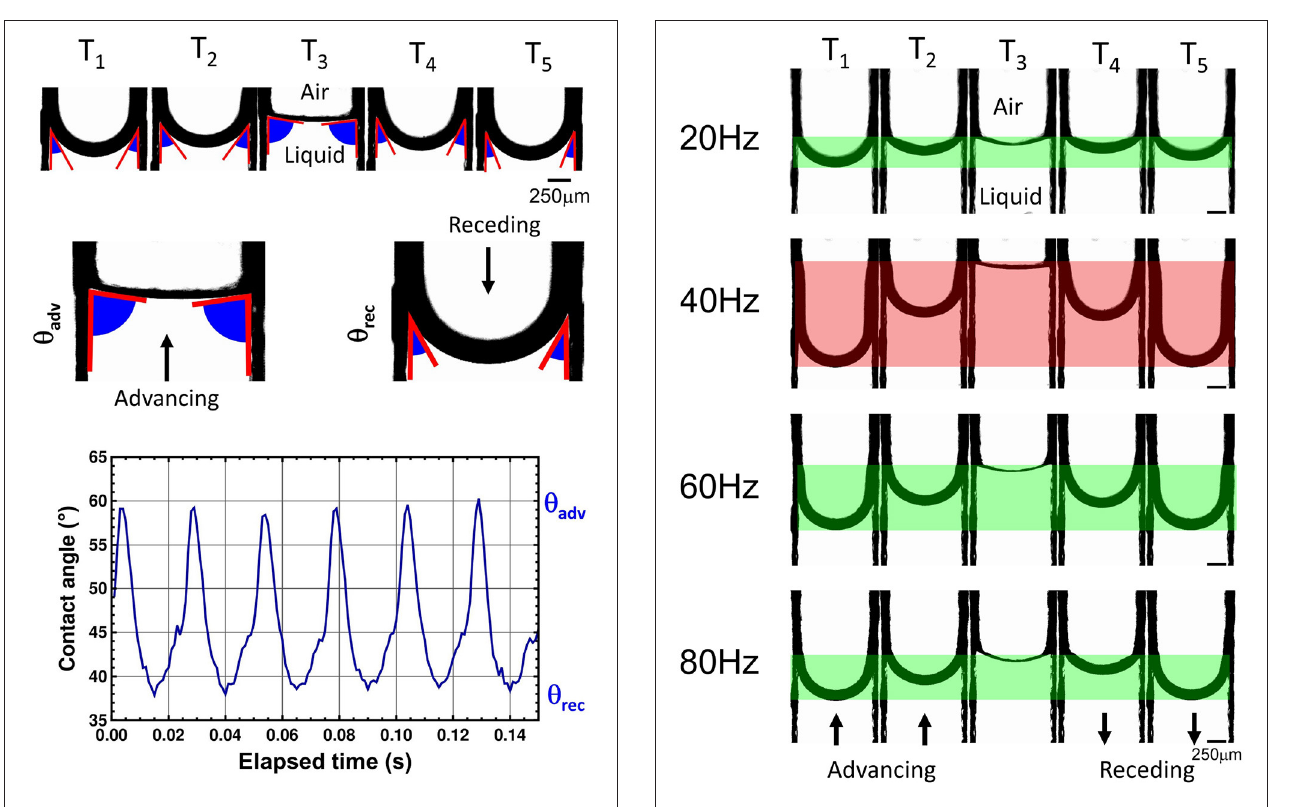
displacement is highlighted in red so the frequency dependent